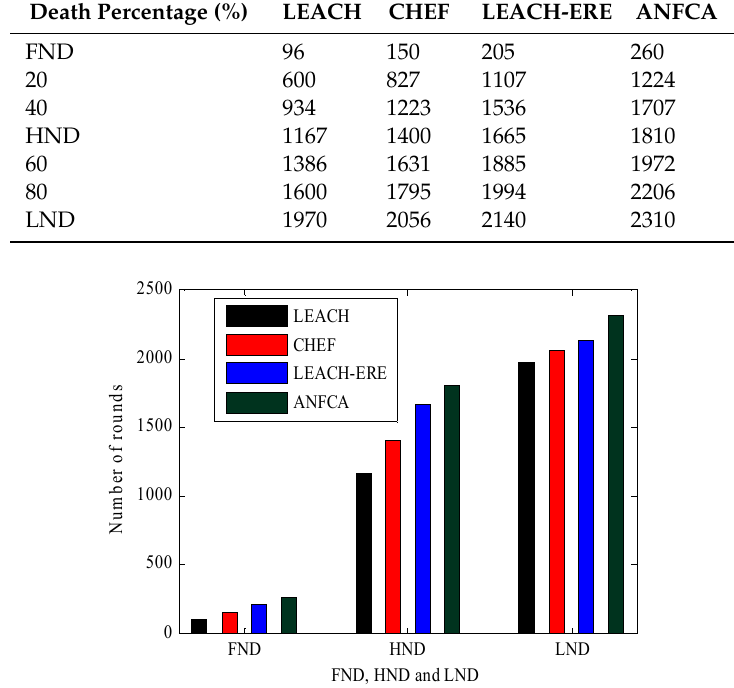
Figure 8. FND, HND, and LND results over the rounds.